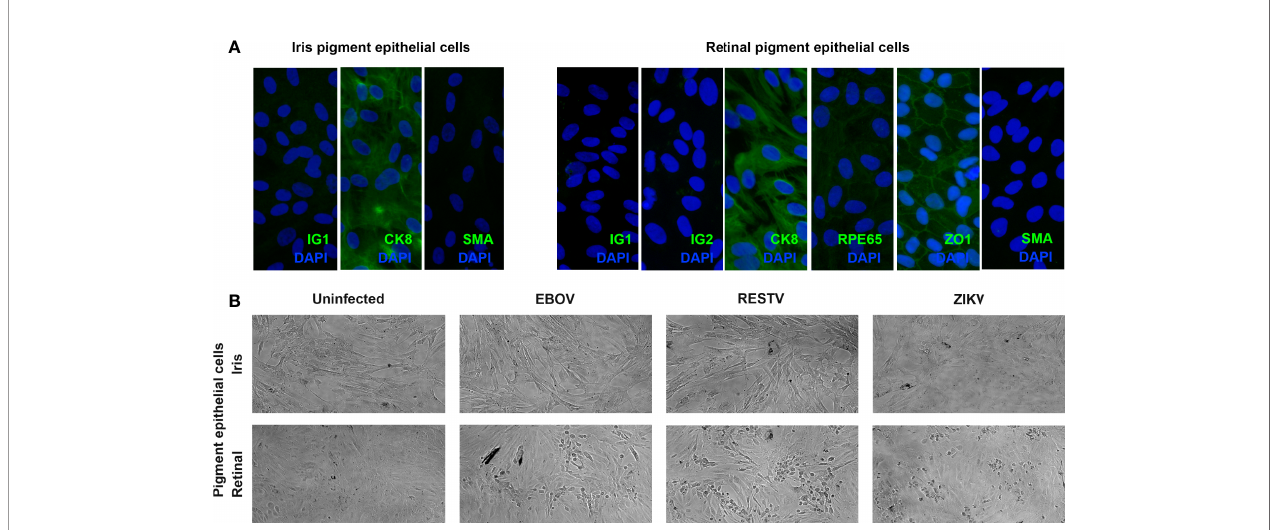
FIGURE 1 | (A) Representative fl uorescence photomicrographs of donor-matched human iris and retinal pigment epithelial cells immunolabelled to detect the presence of cytokeratin 8 (CK8) and absence of alpha-smooth muscle actin (SMA), plus human retinal pigment epithelial cells immunolabelled for retinal pigment epithelium-speci fi c protein 65 (RPE65), and zonula occludens 1 (ZO1), with negative controls labelled with species-matched immunoglobulin (IG1 and IG2). Alexa Fluor 488 (green) with DAPI nuclear counterstain (blue). Original magni fi cation: 400x. (B) Representative light photomicrographs of EBOV-, RESTV- and ZIKV- infected, plus uninfected donor-matched human iris and retinal pigment epithelial cell monolayers 72 hours following inoculation at a multiplicity of infection of 1. Original magni fi cation: